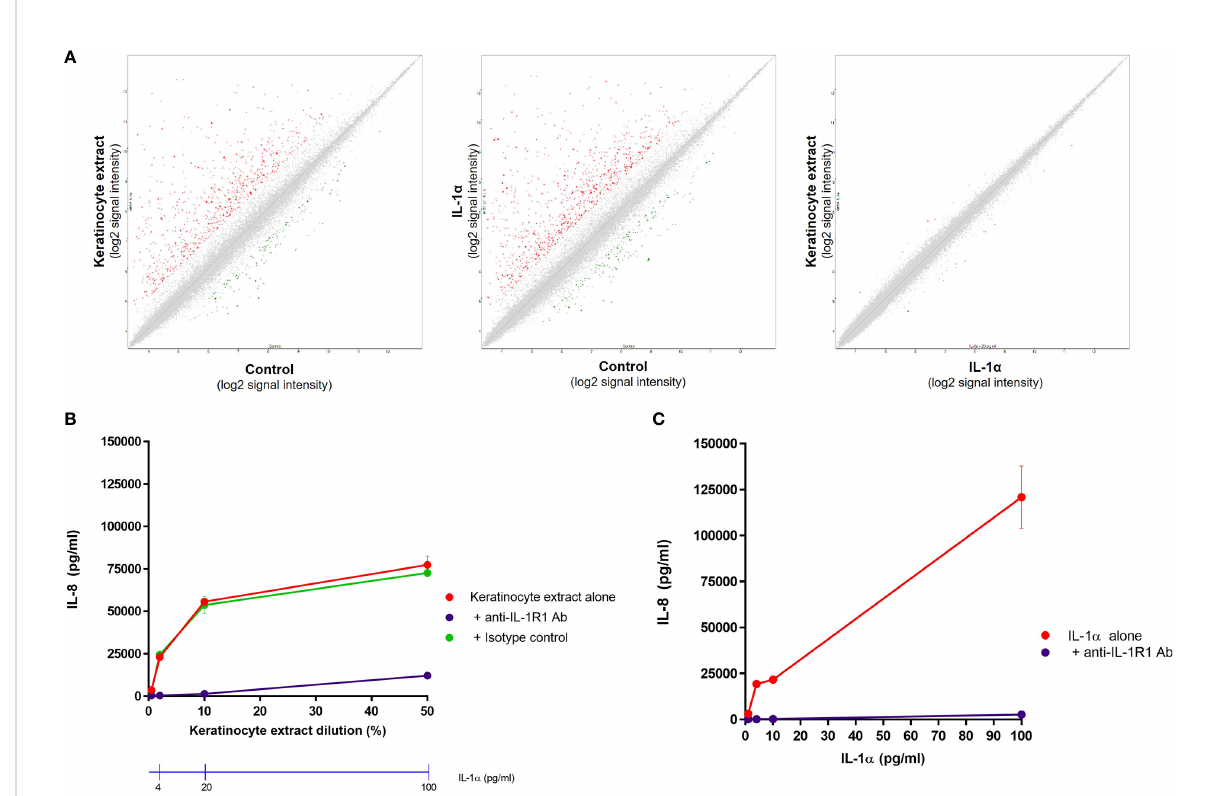
FIGURE 4 The response of dermal fi broblasts to keratinocyte extracts is mainly mediated by IL-1 a / b . Complementary Affymetrix microarray experiments (hU219 array) were performed to analyze the expression of 36000 transcripts (corresponding to ~20000 genes) by normal dermal fi broblasts (control) and fi broblasts stimulated either by keratinocyte extracts (tested at a dilution of 10%, containing ~20 pg/ml of IL-1 a ) or IL-1 a (tested at 20 pg/ml). Comparisons of the transcriptional pro fi les between two conditions were shown, with up-regulated genes shown in red and down- regulated genes in green (A) . Dermal fi broblasts were stimulated by different dilutions of keratinocyte extracts (B) or increasing concentrations of IL-1 a (C) in the presence of an anti-IL-1R1 blocking antibody or an isotype control. Corresponding concentrations of IL-1 a in keratinocyte extracts were also indicated (B)